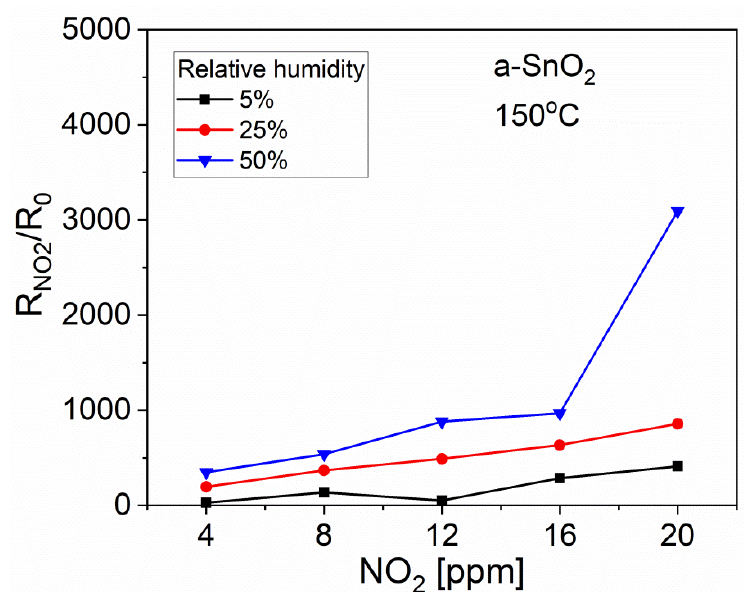
Figure 15. Influence of humidity on the R NO2 / R 0 responses of a-SnO 2 thin films to varying NO 2 concentrations at a constant operating temperature 150 ° C.